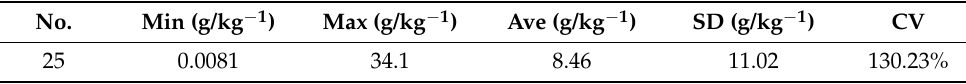
Figure 1. The position of sampling sites in the study area. Table 1. Statistical description of the measured petroleum hydrocarbon content of soil samples (Min: minimum; max: maximum; ave: average; SD: standard deviation; CV: coefficient of